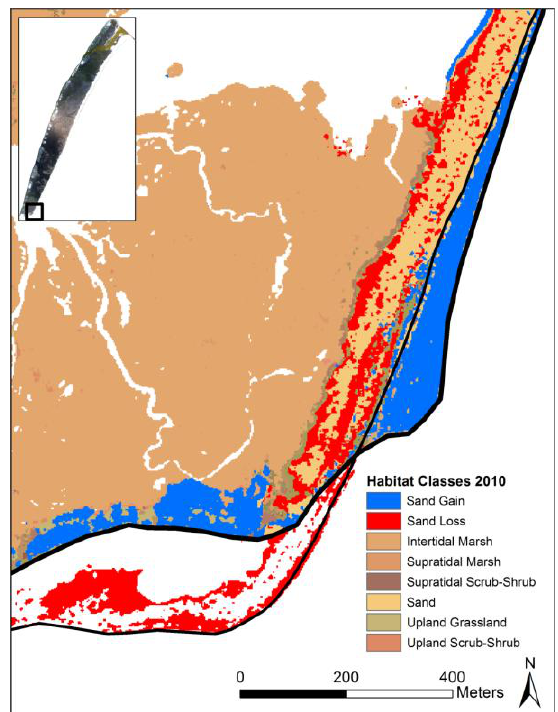
Figure 11. Change in sand at the southern end of Masonboro Island adjacent to Carolina Beach Inlet. Sand erosion (red) and accretion (blue) can be seen along with overall change from 2002 (thin black line) to 2010 (thick black